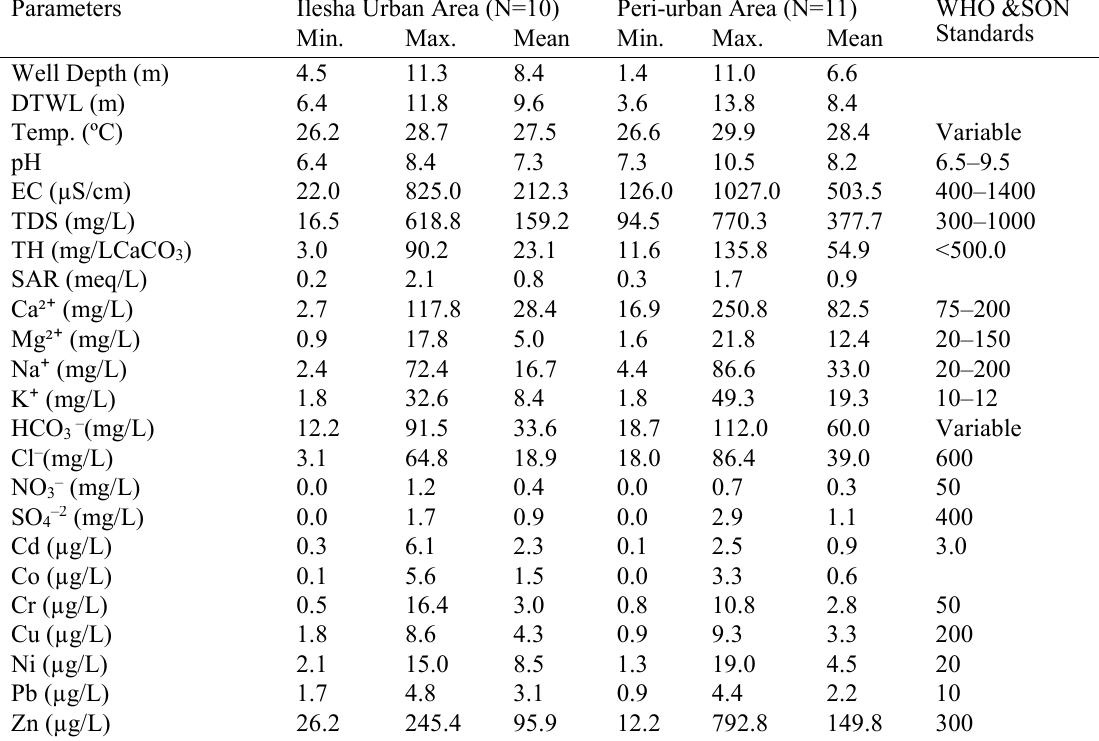
Standards Min. Max. Min.